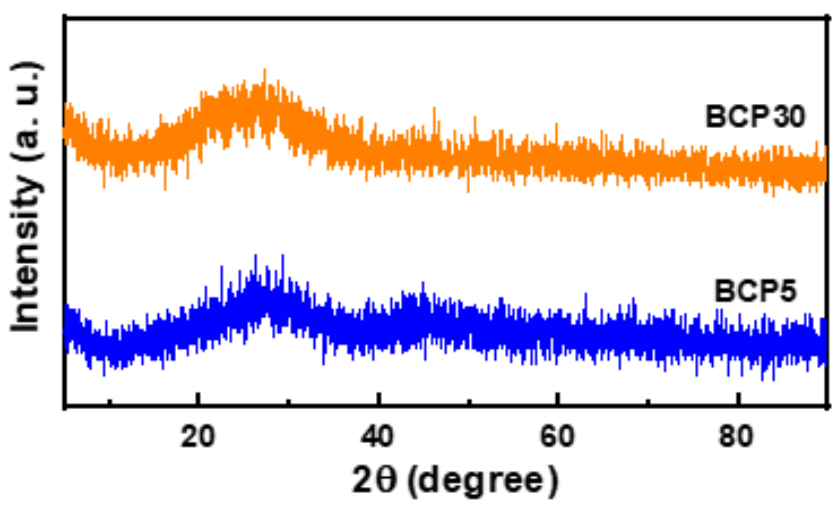
Figure 2. XRD pattern for prepared glasses.